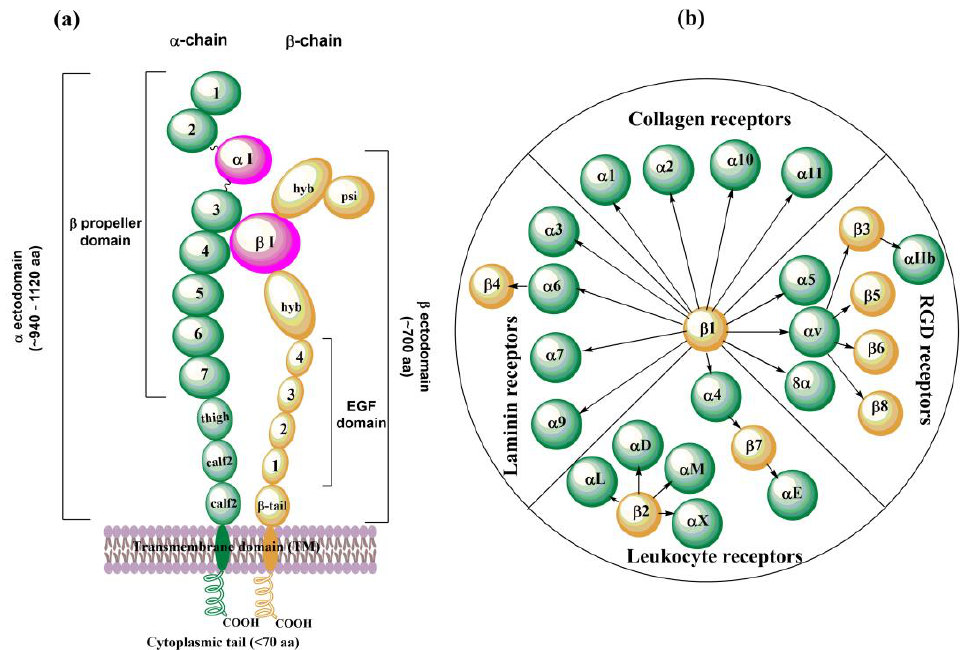
Figure 2. Schematic representation of ( a ) an arrangement of domains in the α - and β -subunit of integrins; ( b ) 24 distinct integrins divided into subfamilies according to their ligand specificities, adapted from ref. [8,15].